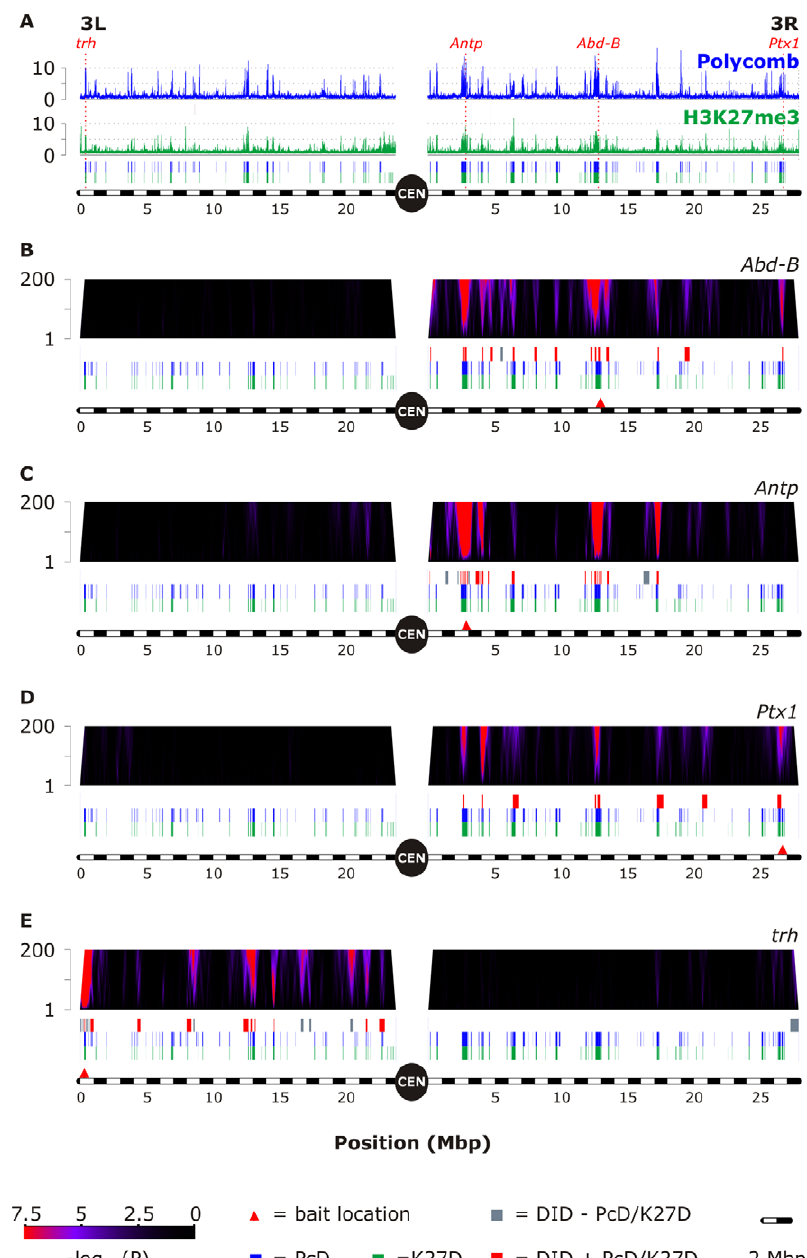
Figure 2. Long-range interactions of PcG target genes. (A) Chromatin profile of third chromosome representing Polycomb binding (blue) and H3K27me3 levels (green) as detected in 3 rd instar larval central brain cells. Below graphs, the blue and green rectangles show Pc (PcD) and H3K27me3 (K27D) domains, respectively. X-axes indicate the chromosomal position (in Mbp), while the fold-change (either PC-Dam over Dam or H3K27me3 over IgG) is shown on the y-axes. Positions of the 4 PcG target baits are indicated (red). (B–E) We mapped long-range chromatin interactions using four different PcG-targets as bait,namely: Abdominal-B ( Abd-B )promoter(B), Antennapedia ( Antp )P1promoter(C), Ptx1 (D),and trachealess ( trh -E).PlotsaredescribedinFigure1B.Notably, the majority of all DIDs (red boxes) coincide with either PcDs (blue boxes) and/or K27Ds (green boxes), and a minority (grey boxes) contacts other